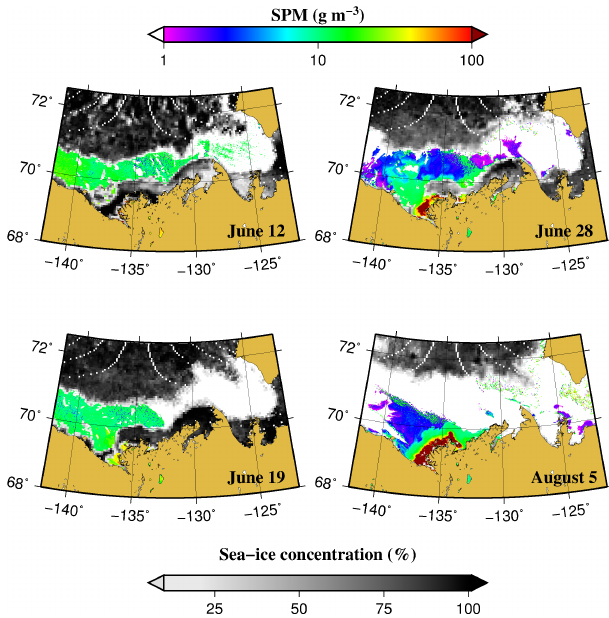
Figure 5. Typical SPM and sea-ice concentration (in grams per cu- bic meter and percent, respectively) maps obtained over the study area for selected days in June, July and August 2004. From June to July the breaking of the stamukha results in the discharge of turbid freshwater from the Mackenzie River into the Beaufort Sea. Even during the summer period the delta zone remains the most turbid area (maximal SPM